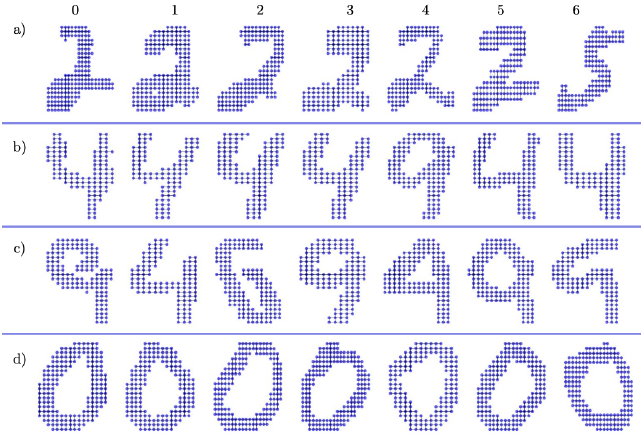
Figure A1. Six nearest neighbors of graphs in latent space from MNIST for four graphs. Column 0 correspond to the randomly chosen graph then the six nearest neighbors are draw in increasing distance order from left to right (from 1 to